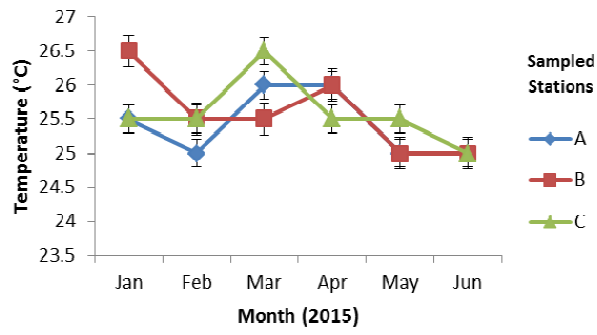
Fig. 2. The monthly mean variation of water temperature (°C) of the water sampled from Saba